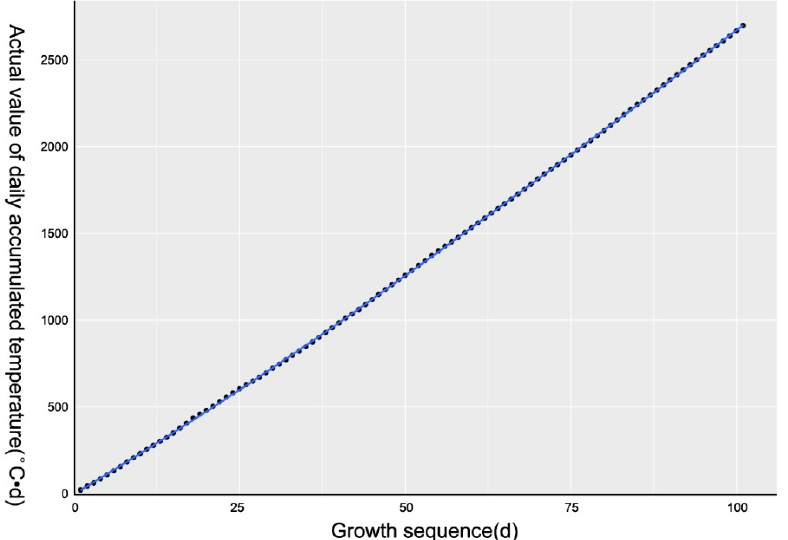
Figure 5. Scatter plot of daily accumulated temperature during the whole growth period of pepper. G Skewness was fitted by the local polynomial regression-fitting algorithm, which was implemented by the geom_smooth function of R. X axis was the sequence of daily leaf age, and Y axis was the value of the daily accumulated temperature.